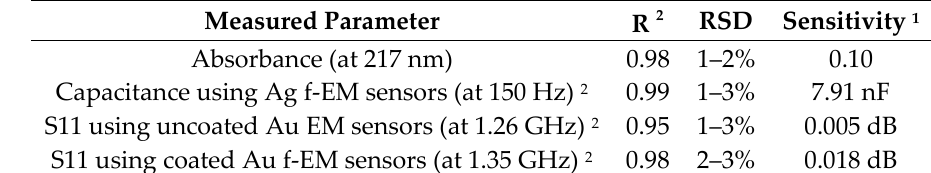
Table 1. Linear correlation (R 2 ), relative standard deviation (RSD) and sensitivity for Cu samples using optical, electrical and microwave methods combined with f-EM sensors.